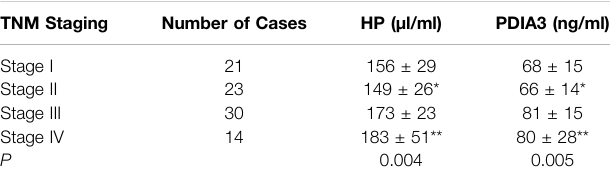
TABLE 4 | Comparison of HP and PDIA3 levels in patients with different TNM stages of colorectal cancer ( x ± s ). *vs. Stage I ( p > 0.05),**vs. Stage III ( p >